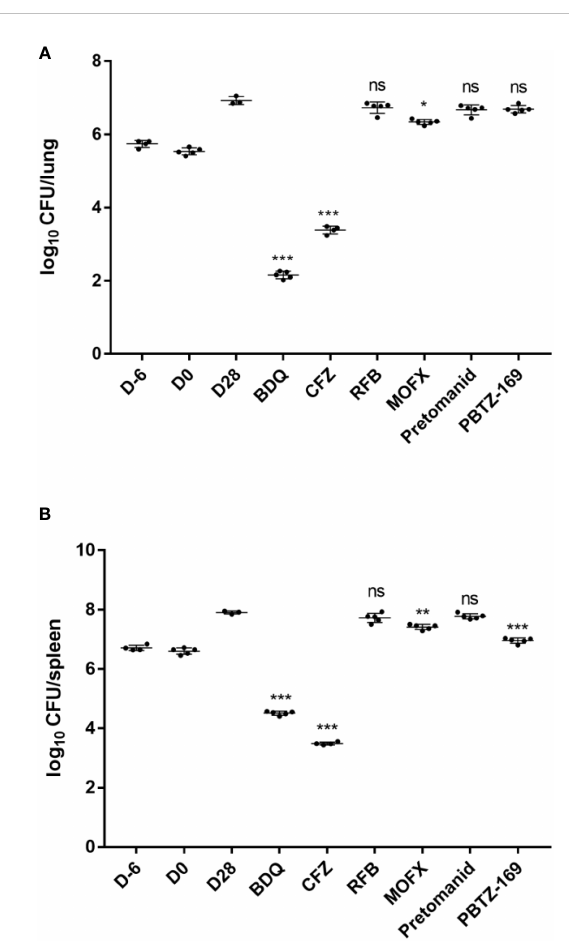
FIGURE 3 Mean number (log 10 ) of CFU per lung (A) and spleen (B) in various groups of mice infected with M. abscessus. Four mice failed to infect due to operational reasons (1 each from RFB, MOFX, pretomanid and PBTZ169 group). Three mice died during the treatment period (1 each from CMC, RFB, and MOFX group).*P <0.05; **P <0.01; ***P <0.001; “ ns ” indicates no statistically signi fi cant difference between the two